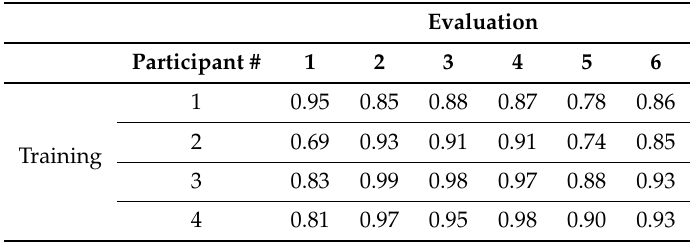
Table 8. Median accuracy rates for each combination of training and evaluation participants. Results were obtained through the use of Euclidean distance minimization on RSS data from a 7-node 433 and 868 MHz